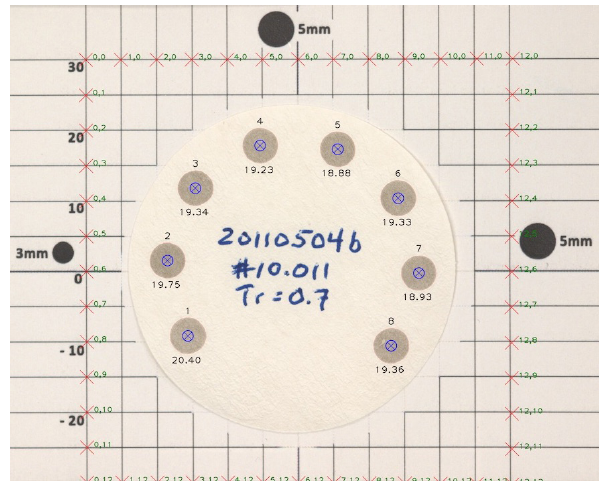
Figure 4. Example of photographic analysis of spot area. Numbers 1–8 above each spot indicate spot number, while the numbers below each spot indicate spot area inmm 2 .